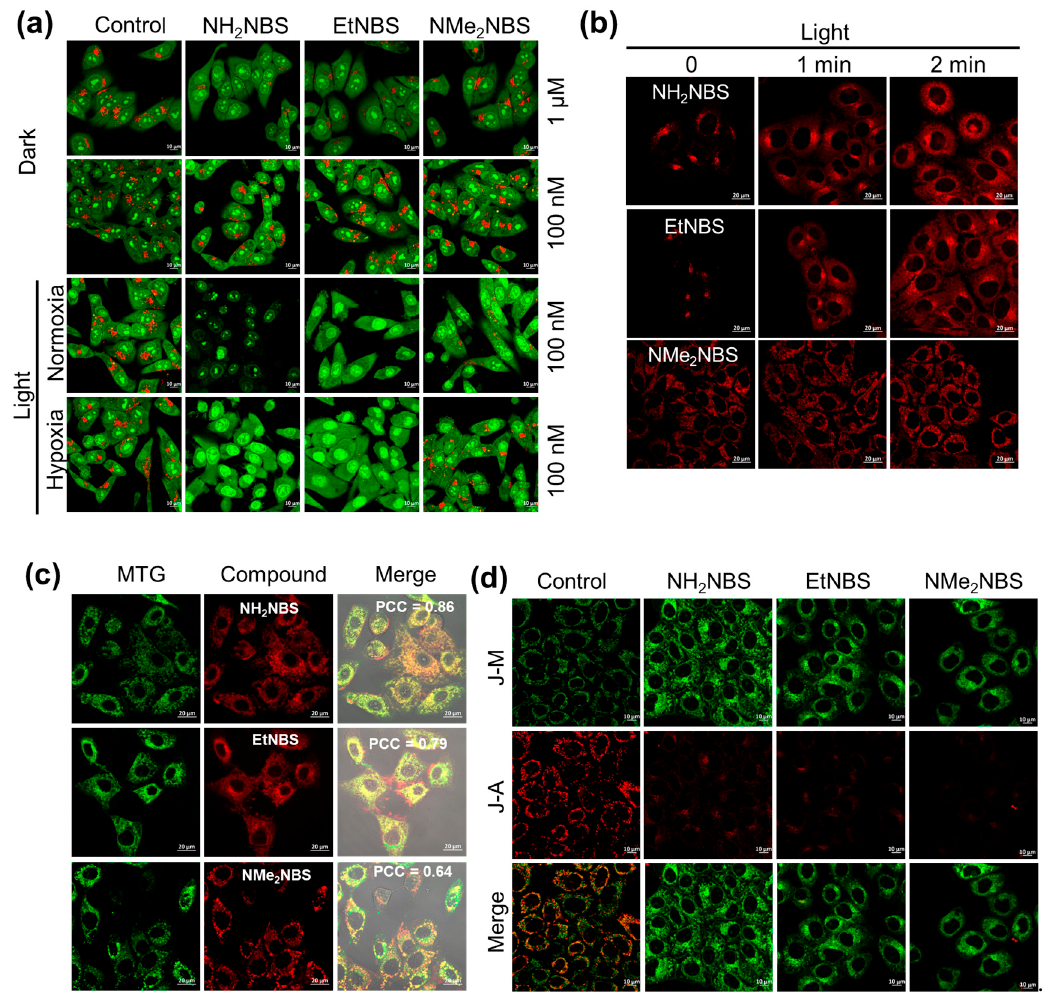
Figure 4. ( a ) CLSM images of AO (5 μ M) staining. ( b ) The confocal fluorescence images of NH 2 NBS, EtNBS, and NMe 2 NBS (100 nM), after (different times of) 635 nm irradiation at a power density of 20 mW/cm 2 . ( c ) Cellular colocalization images after NIR light irradiation. ( d ) MMP determination after NIR light irradiation by JC-1. J-A represents the aggregation type and J-M represents the monomer type of JC-1. The concentrations of NH 2 NBS, EtNBS, and NMe 2 NBS are 100 nM.